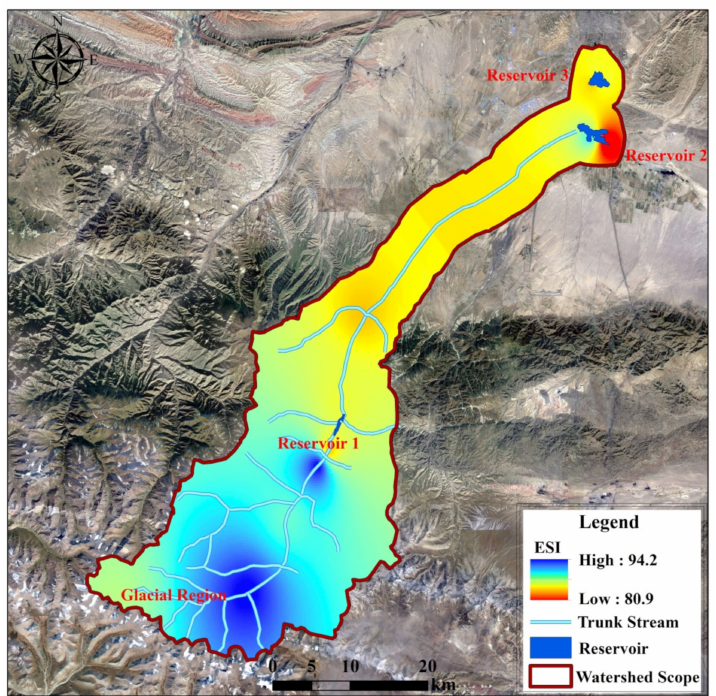
Figure 4. Ecological security index (ESI) values throughout the entire study area.